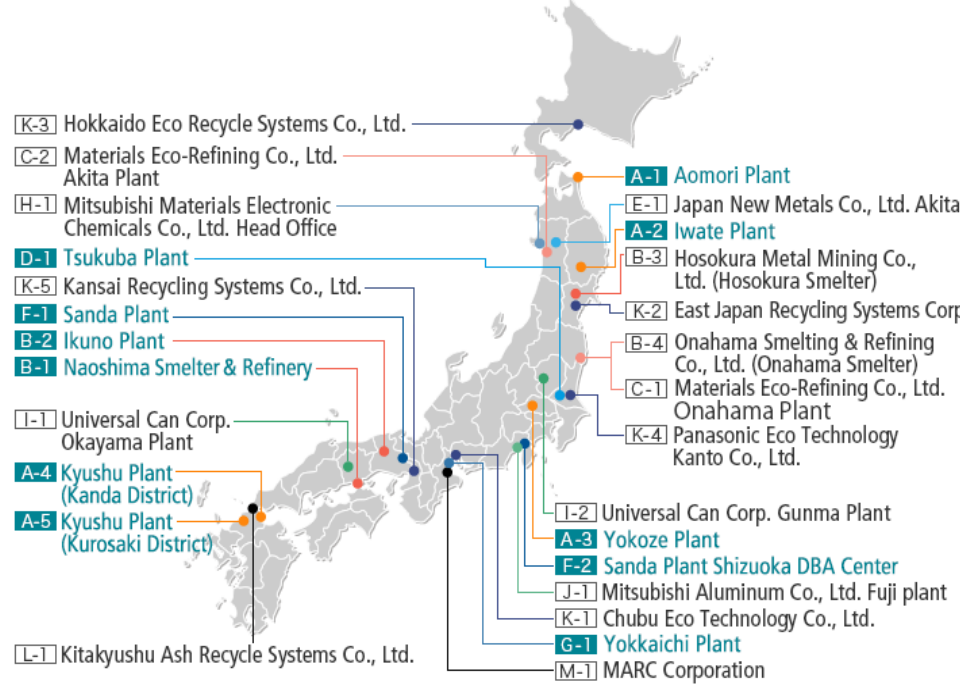
Source: Mitsubishi Corporation. Mineral Resources Group